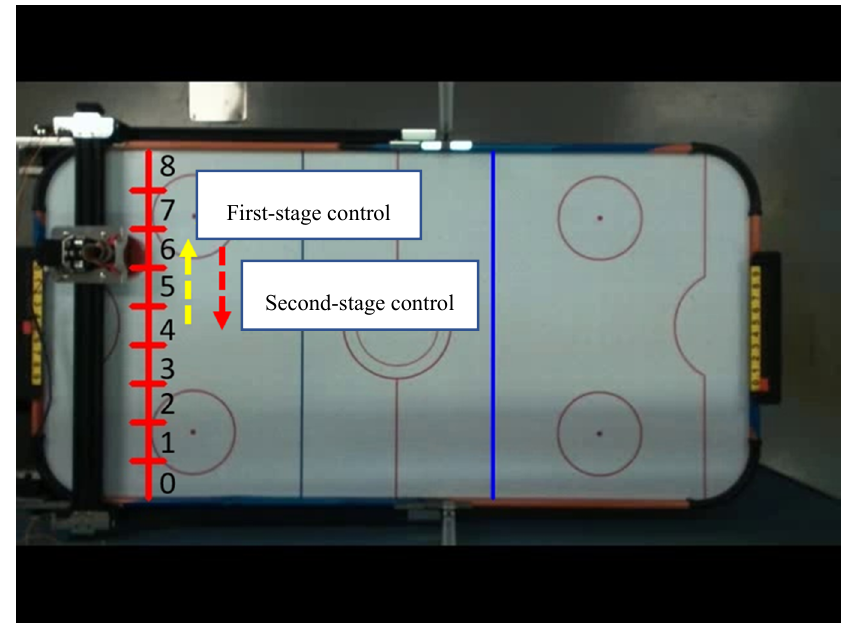
Figure 23. Diagram of different moving directions. Sensors 2020 , 10 , x FOR PEER REVIEW